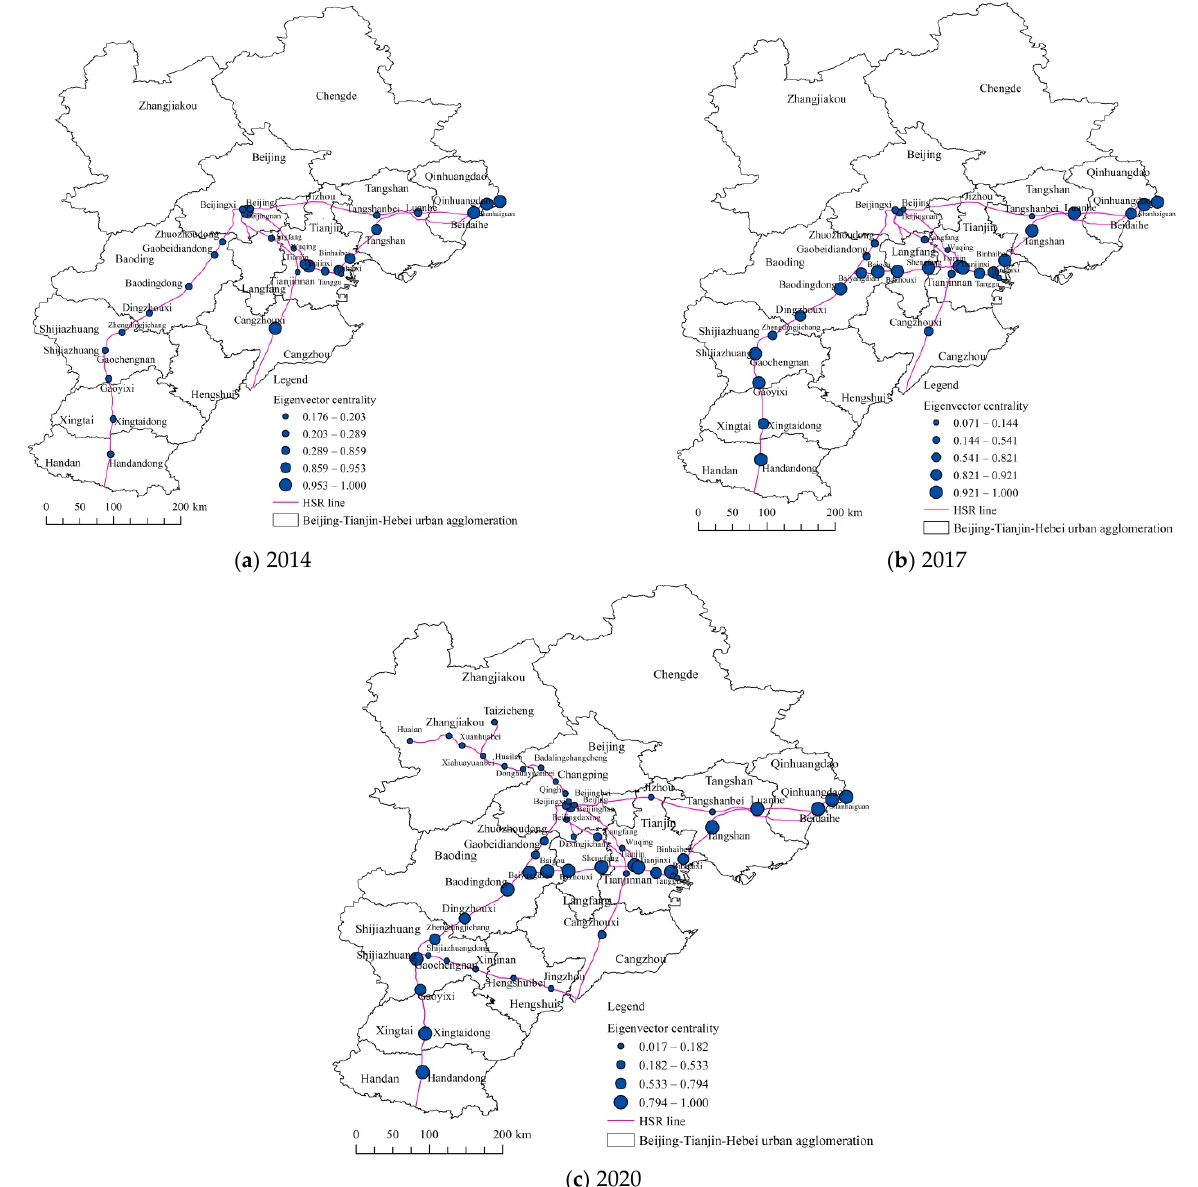
Figure 3. The distribution of the eigenvector centrality index for HSR stations in the Beijing-Tianjin-Hebei urban agglomeration.